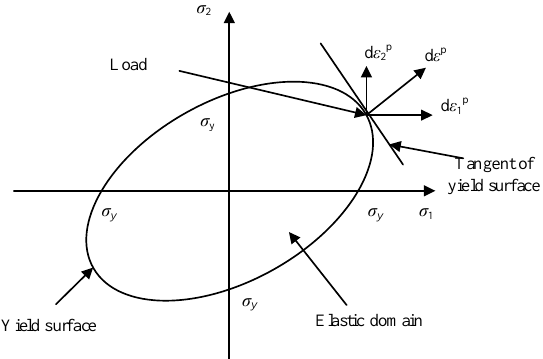
Figure 14. Schematic diagram of von Mises yield criterion under plane stress state.